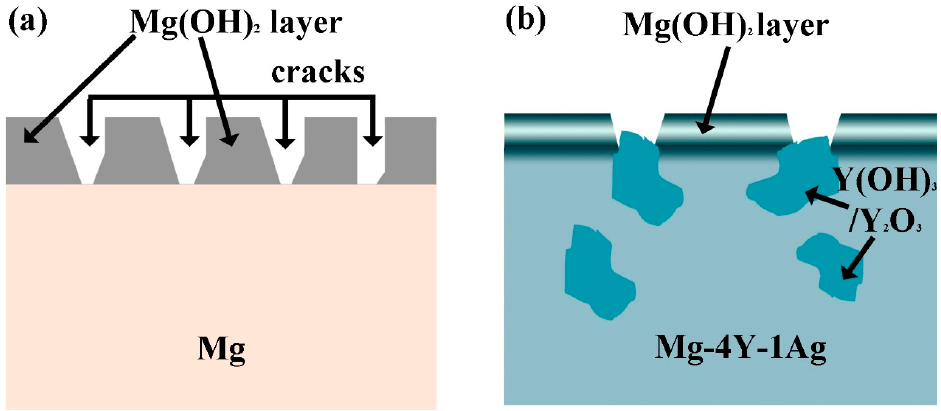
Figure 10. Surface corrosion layer formation on Mg and Mg ‐ 4Y ‐ 1Ag after exposure to SBF solution: ( a ) Mg; ( b ) Mg ‐ 4Y ‐ 1Ag.